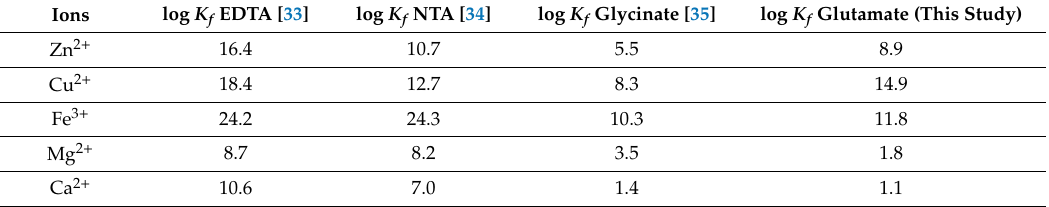
Table 1. Log complex formation constant of metal ions with three organic compounds as chelator / lixiviants. Ions